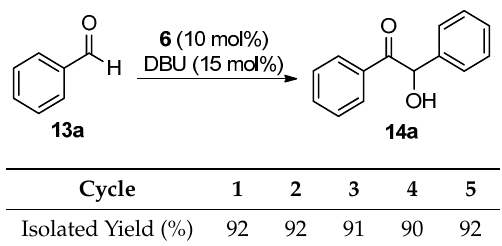
Table 3. Recycling experiments using polymer 6 a .